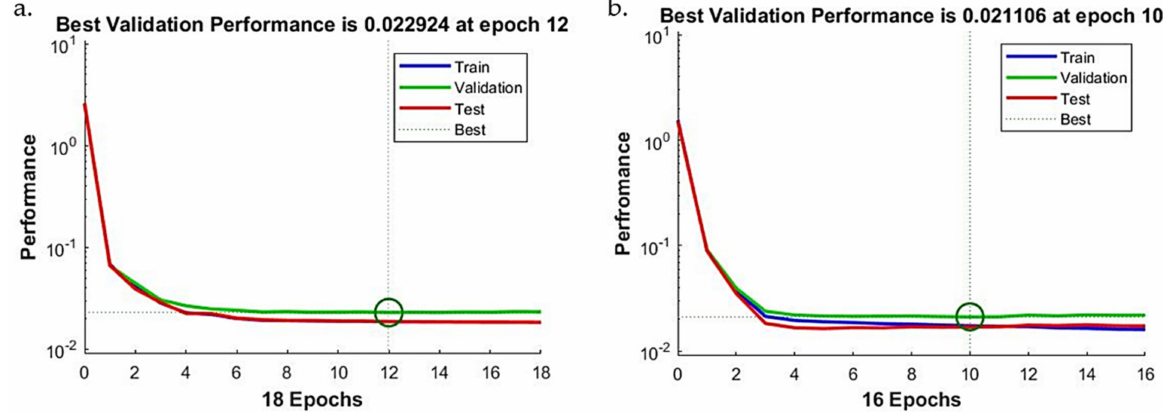
Figure 11. Training performance graphs for ( a ) weekdays ( b ) weekends.